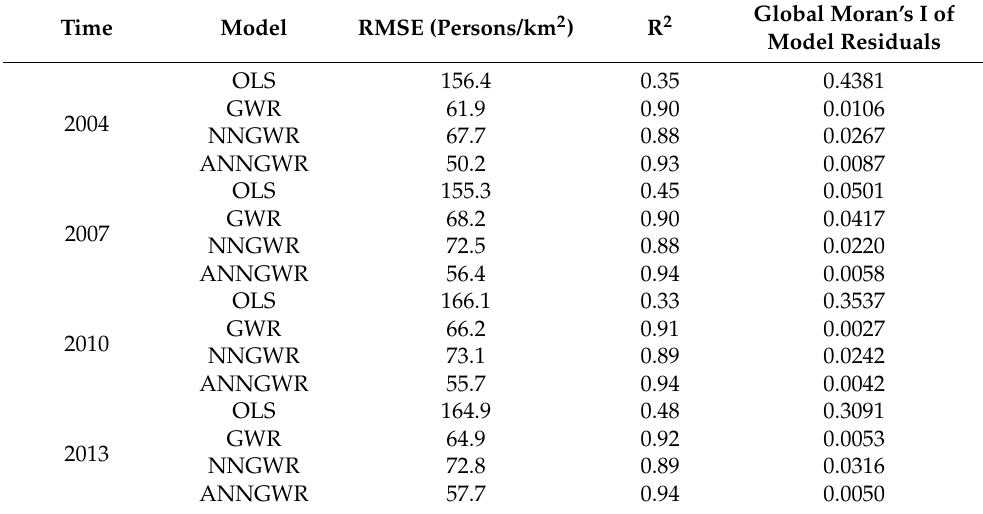
Table 1. Model performance of the four models: (a) OLS, (b) GWR, (c) NNGWR, and (d) ANNGWR. Time Model RMSE (Persons/km 2 ) R 2